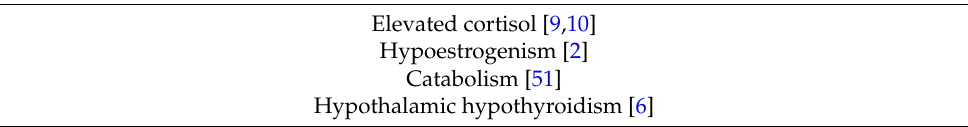
Table 1. Important metabolic aberrations in Functional Hypothalamic Amenorrhea (FHA) that may contribute to compromised brain